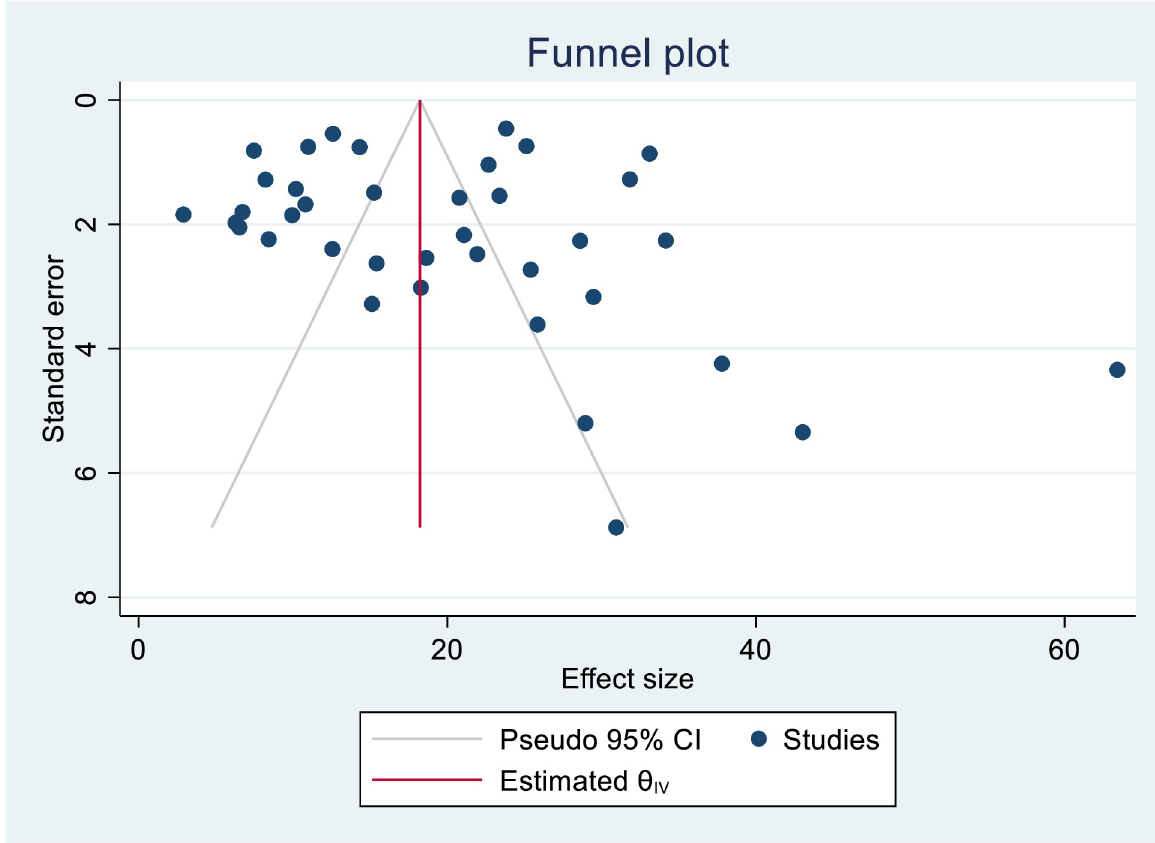
Fig 8. Funnel plot showing publication bias among studies used to compute the incidence of mortality in patients with multi drug-resistant tuberculosis.